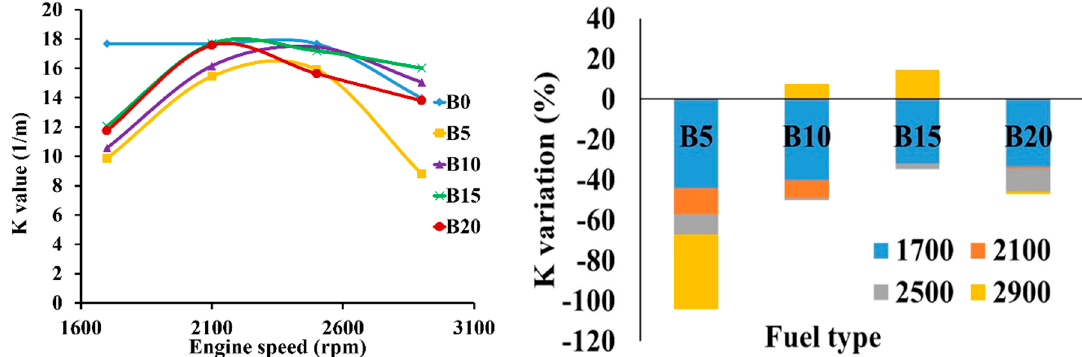
Figure 19. Variation of k value (1/m) for different engine speeds and diesel biodiesel blends at full load.